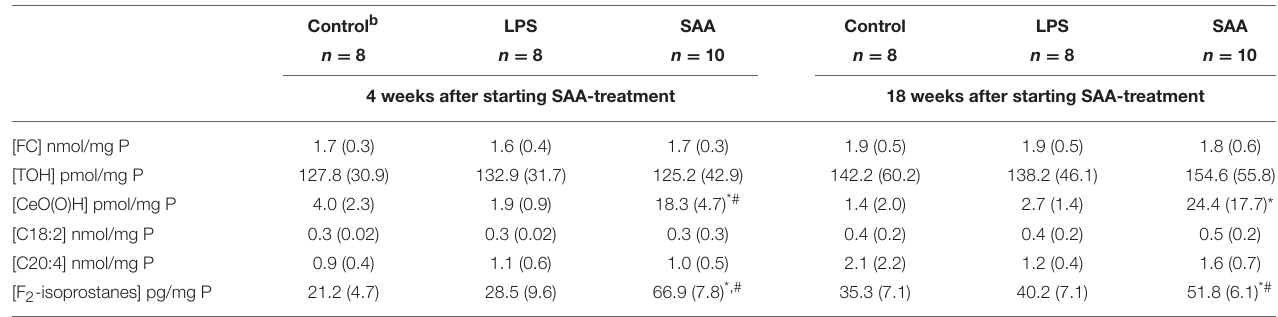
TABLE 3 | Kidney tissue concentrations of native and oxidized lipids and vitamin E a